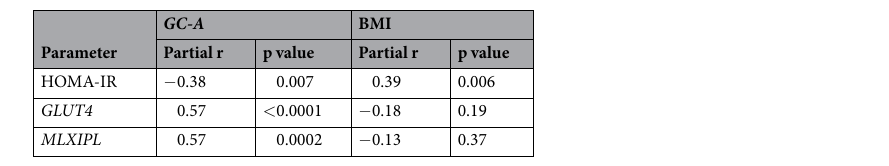
Table 1. Correlations between adipose GC-A gene expression and HOMA-IR, and adipose GLUT4 and MLXIPL (ChREBP) gene expression after adjustment for